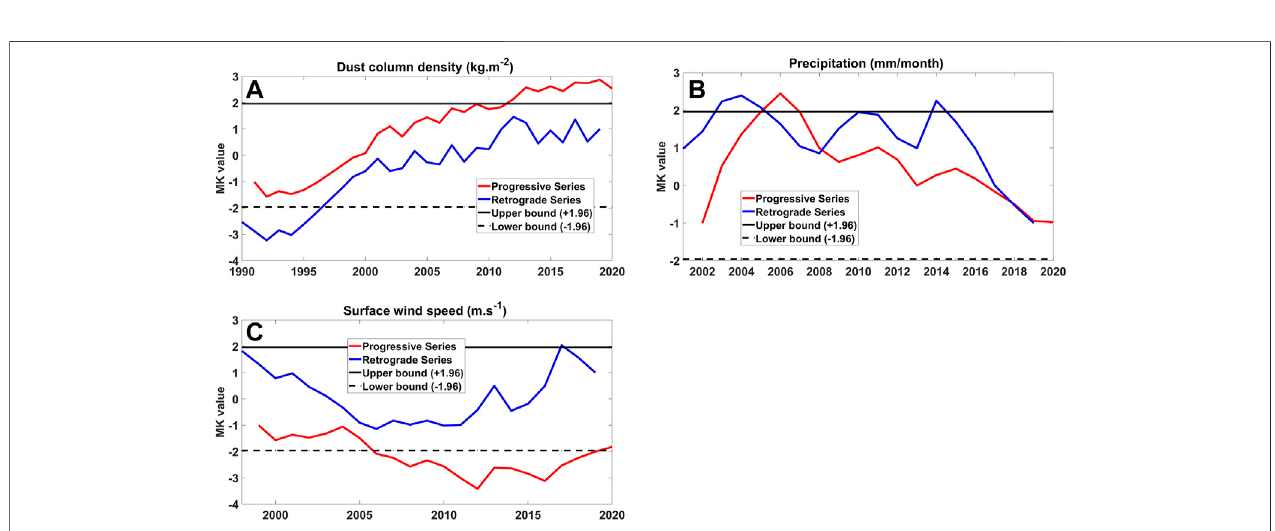
FIGURE 8 | Progressive series and retrograde series trends from the SQMK test for (A) dust column density, (B) precipitation rate and (C) surface wind speed.